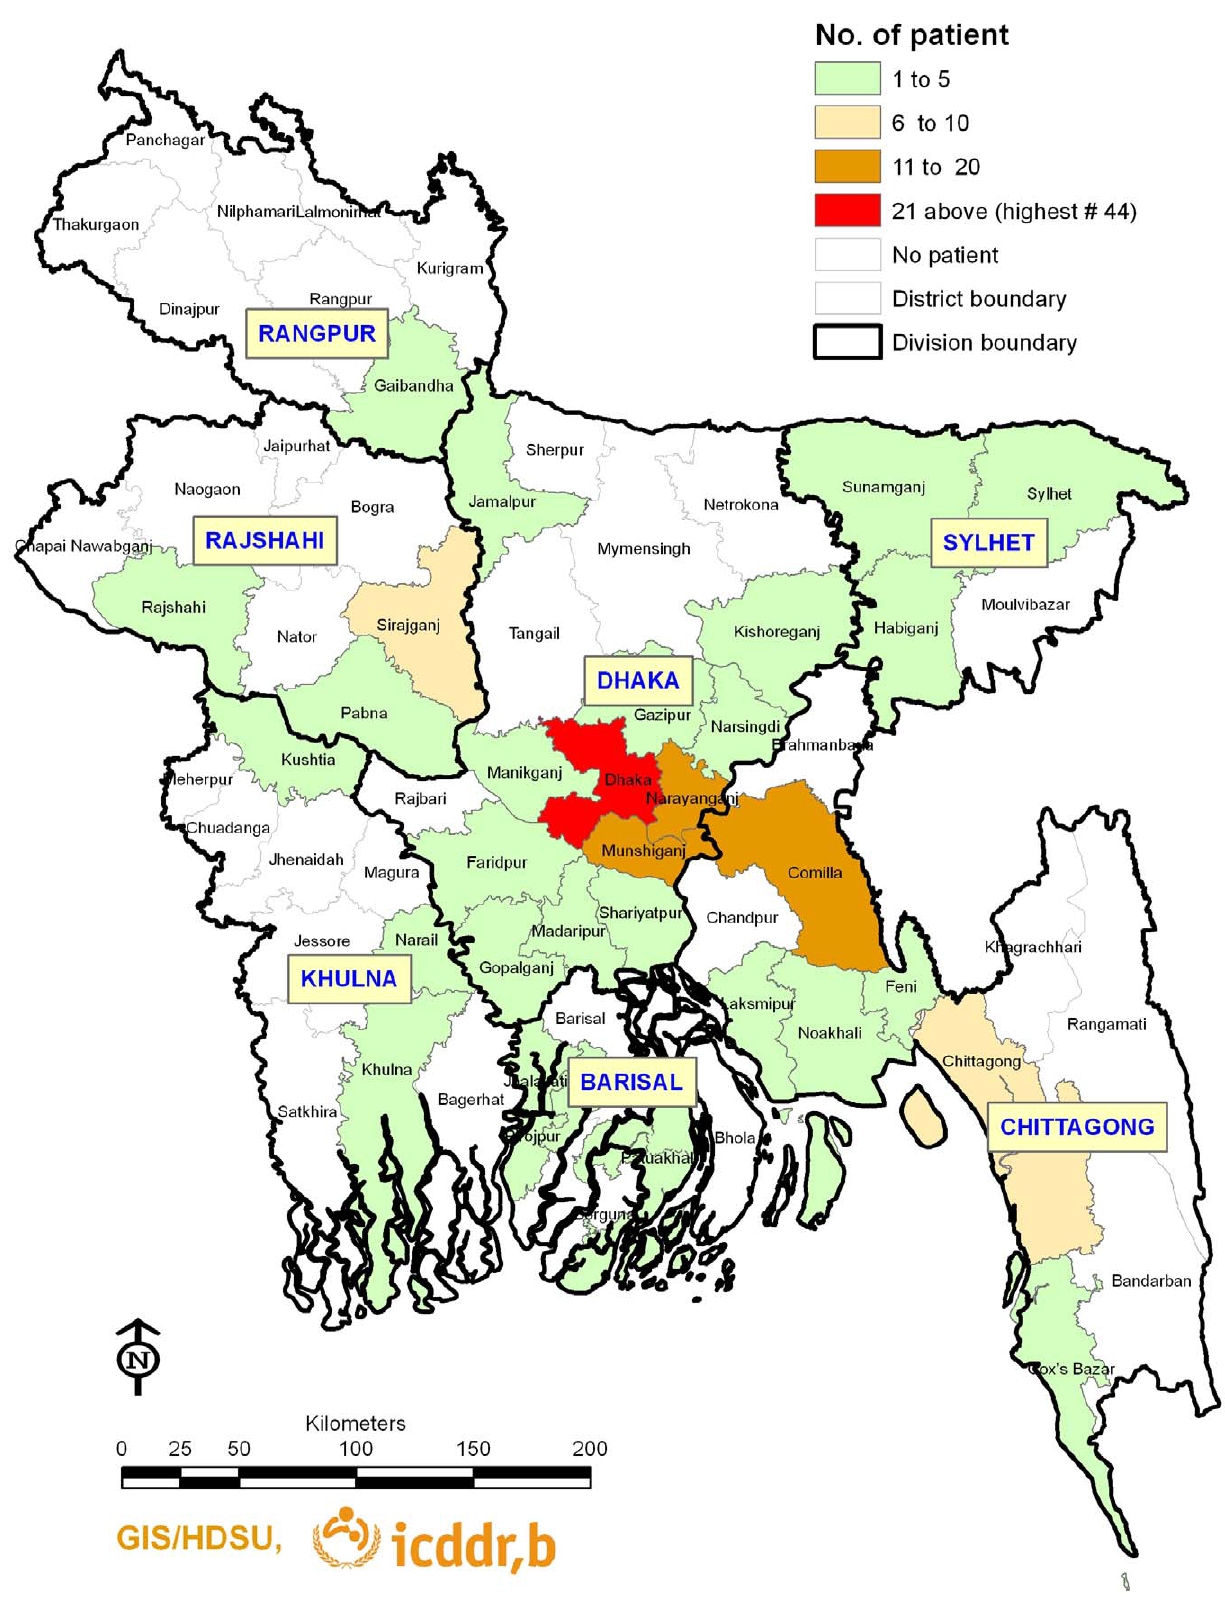
Figure 2. Map of Bangladesh showing the locations of TB cases.